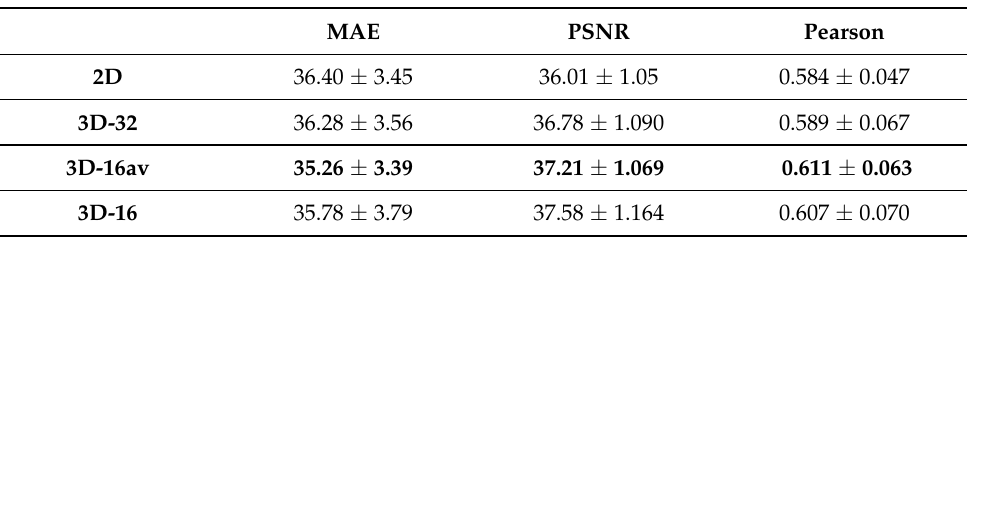
Table 27. Pelvis dataset Soft-tissue with Residual-net. Mean Absolute Error, PSNR and Pearson coefficient from Residual-net using different convolutions and reconstructions in the Pelvis data set within the soft